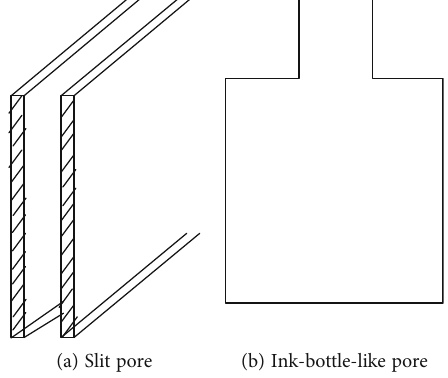
Figure 4: Main simpli fi ed pore structure in gas